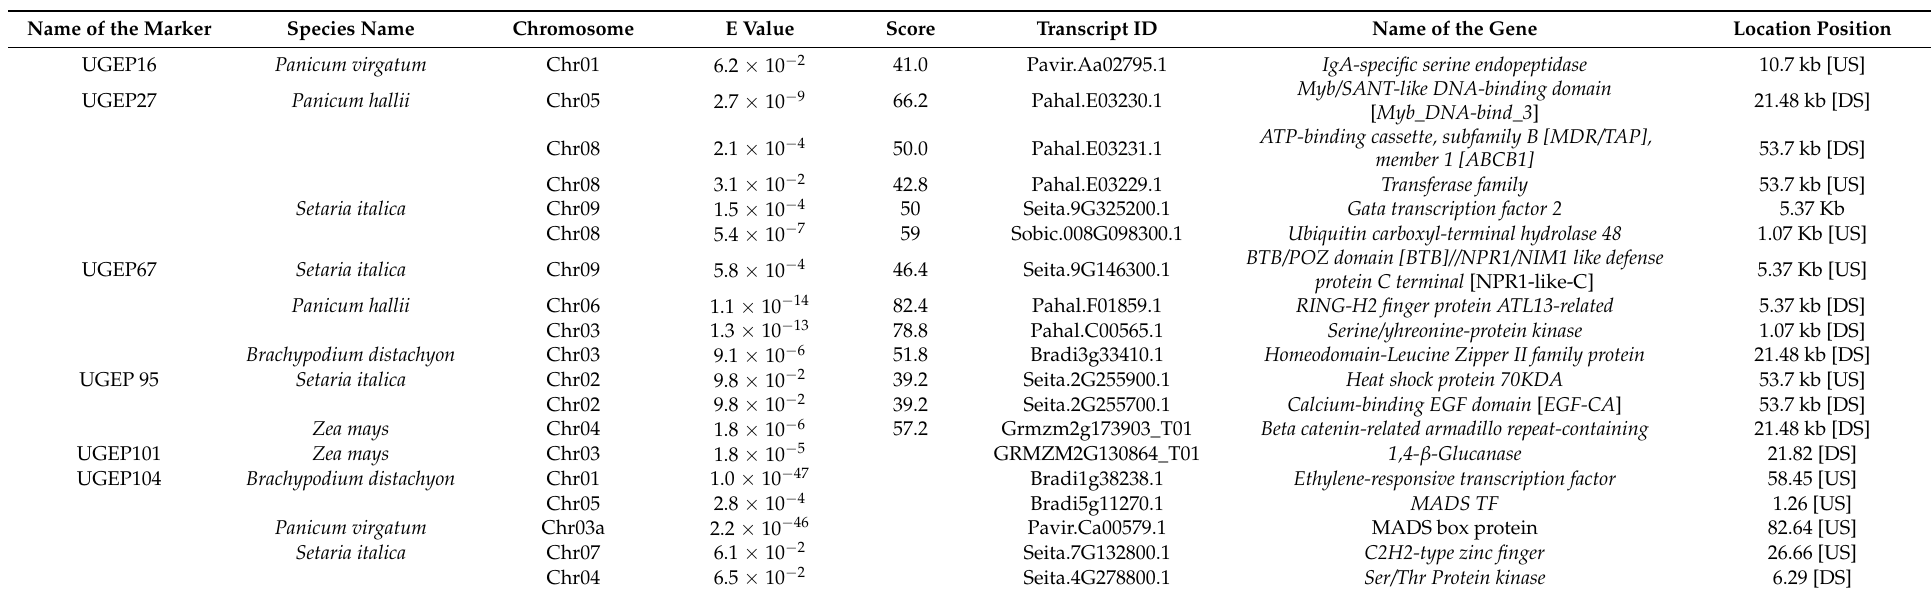
Table 6. Details of candidate genes linked to the QTL, identified with SSR markers of finger millet in different members of the Poaceae